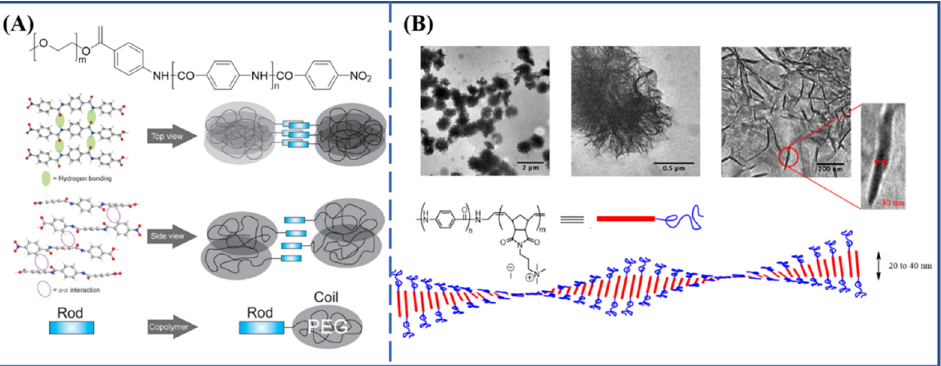
Figure 3. ( A ) Chemical structure and schematic self-assembly behavior of aramid- b -PEG [32]. Copyright 2010 American Chemical Society (Washington, DC, USA). ( B ) TEM pictures and schematic self-assembly behavior of amphiphilic aramid–ROMP block copolymer [34]. Copyright 2017 American Chemical Society.